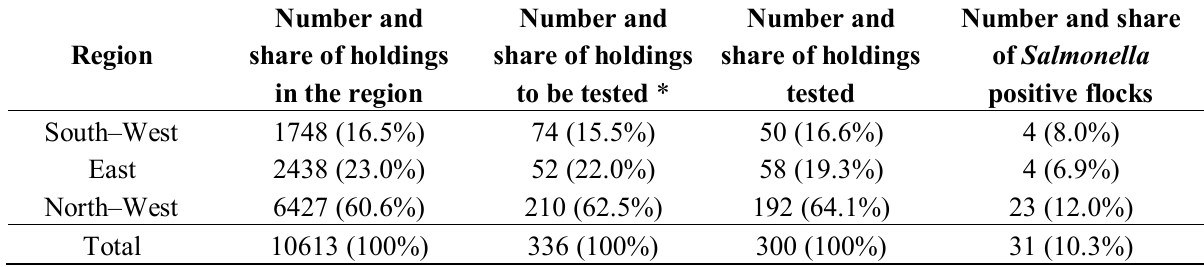
Table 2. Implementation of the baseline survey in fattening flocks in Germany and Salmonella prevalence by